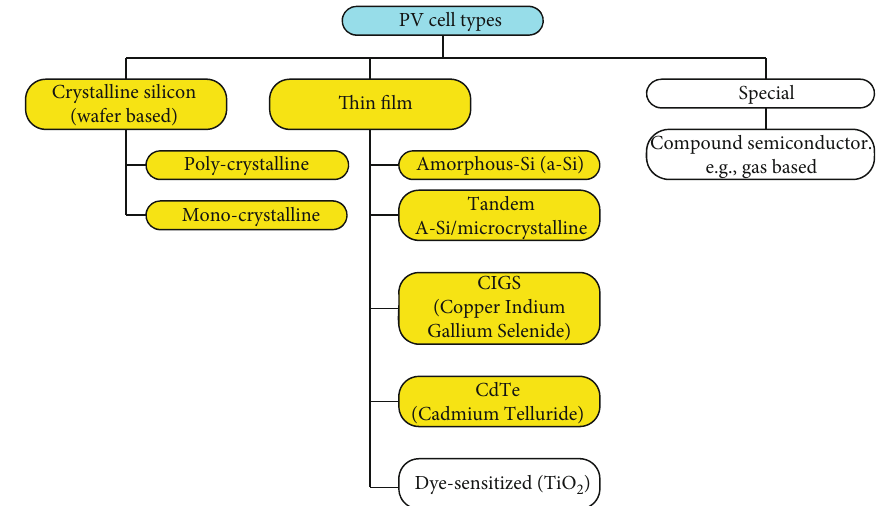
Figure 8: Common PV module technology [37].